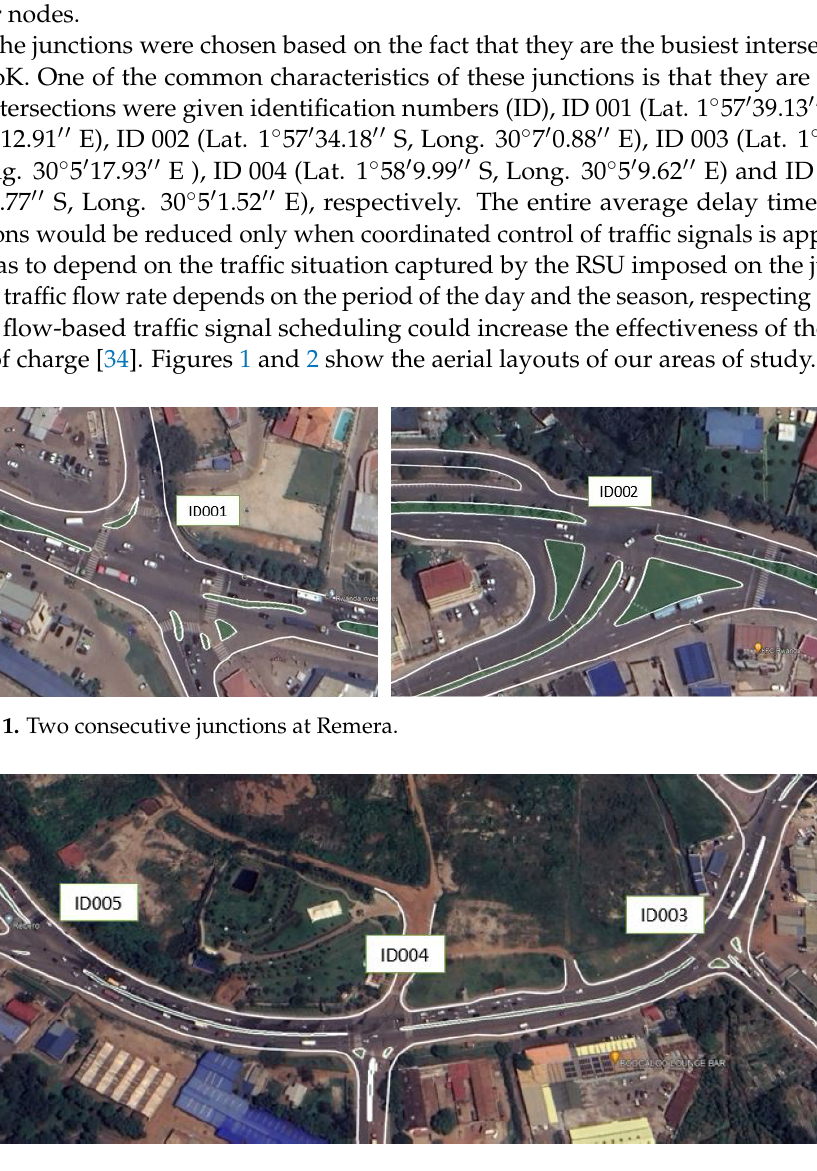
Figure 2. Three consecutive junctions at